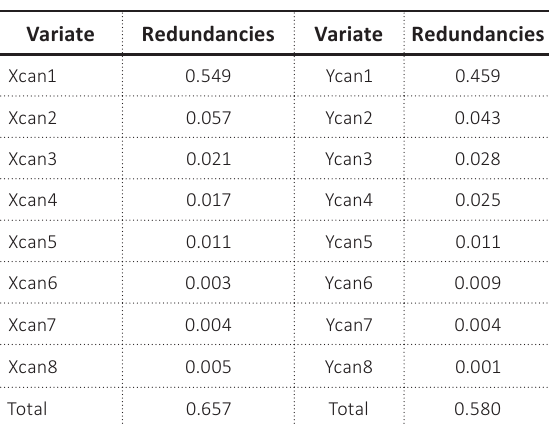
Table 10. Redundancy for canonical variates Xcan and Ycan